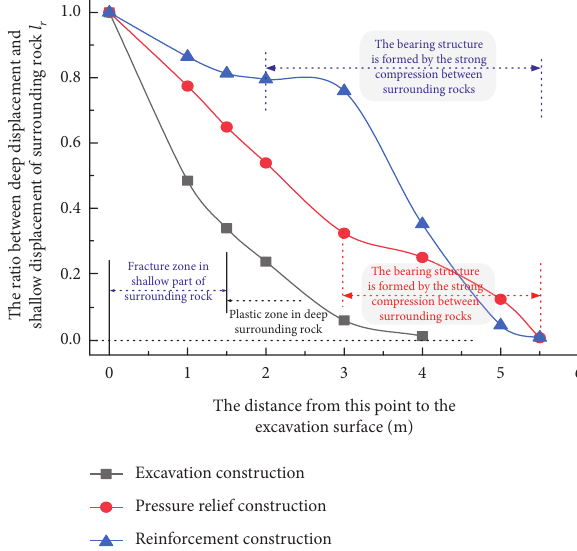
Figure 6: Deep-surface ratio of roadway surrounding